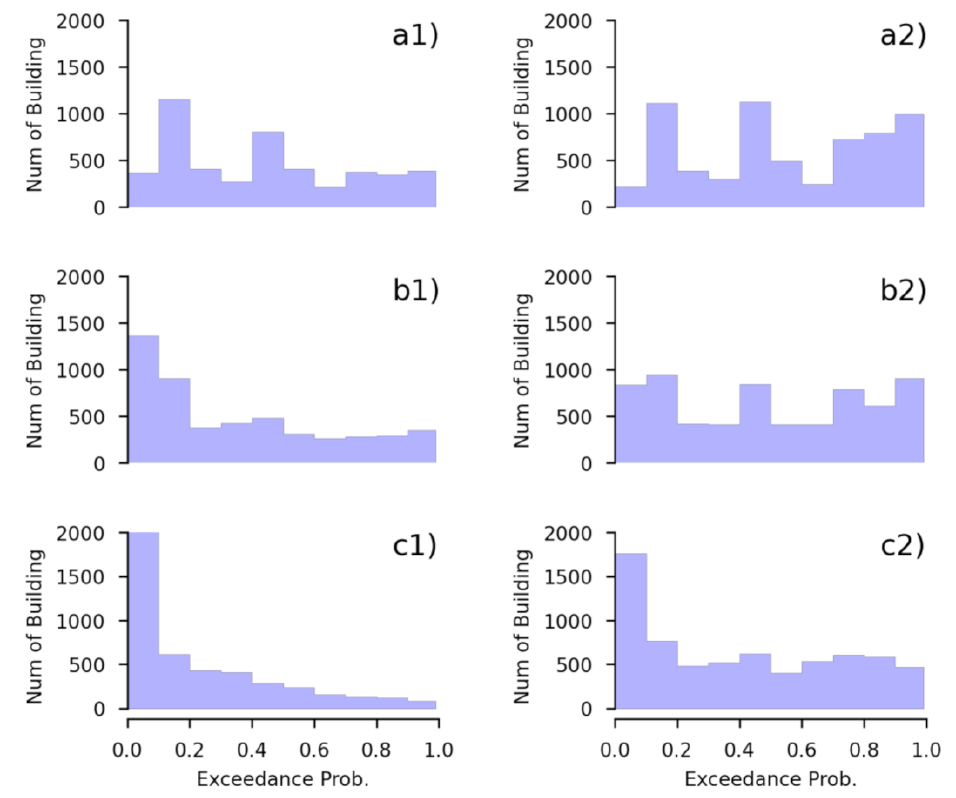
Figure 15. Summary of the number of buildings in each exceedance probability range of 0.1 in all the inundated buildings around the coastal area of Taal Lake. ( a ) probability of experiencing a tsunami inundation depth of more than 0.5 m, ( b ) probability of experiencing a tsunami inundation depth of more than 1.5 m and ( c ) probability of experiencing a tsunami inundation depth of more than 3.0 m; the right column corresponds to the northern area and the left column corresponds to the southern